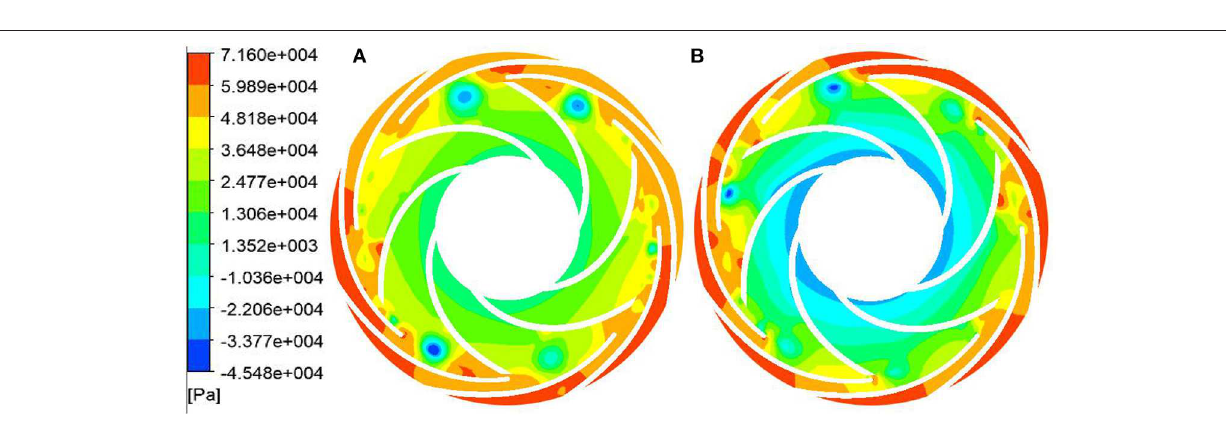
that is, the dynamic pressure head and the static pressure head are increasing. However, compared with the stable speed starting process at the corresponding moment, the